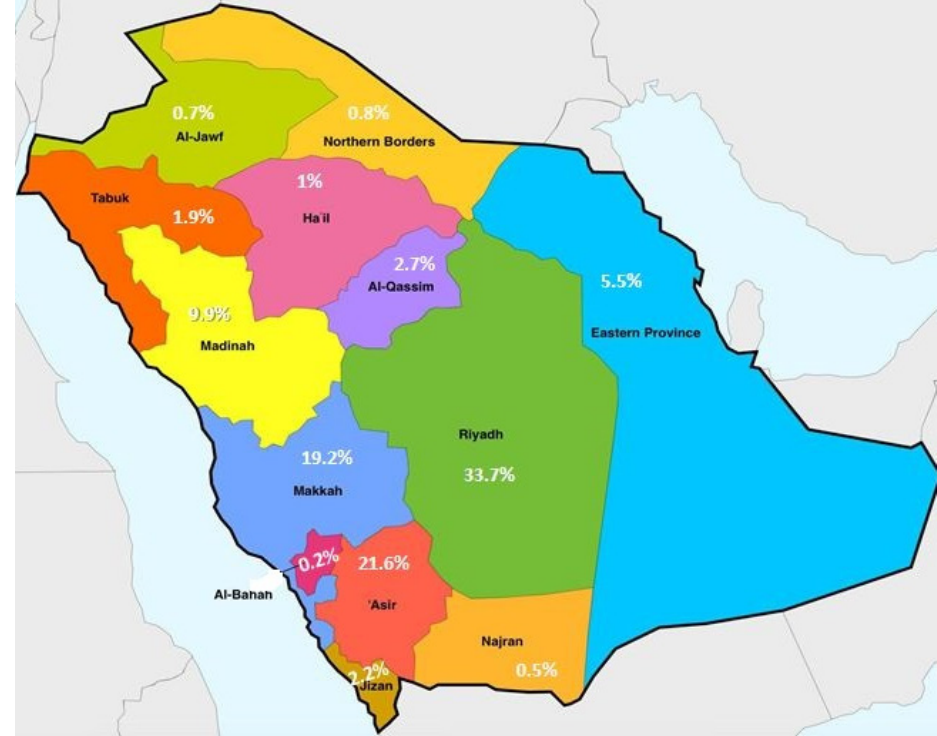
Figure 1. Distribution of participants based on the region in Saudi Arabia.